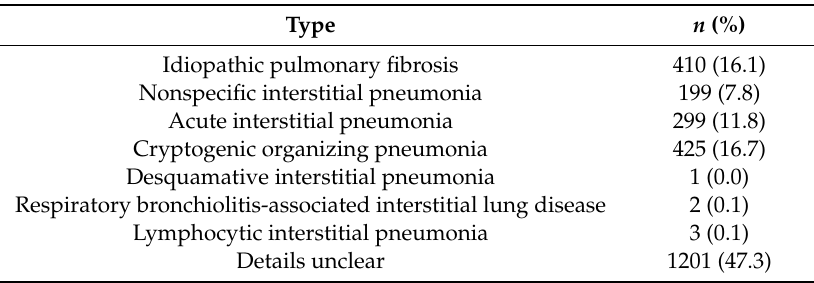
Table 1. Types of idiopathic interstitial pneumonias.